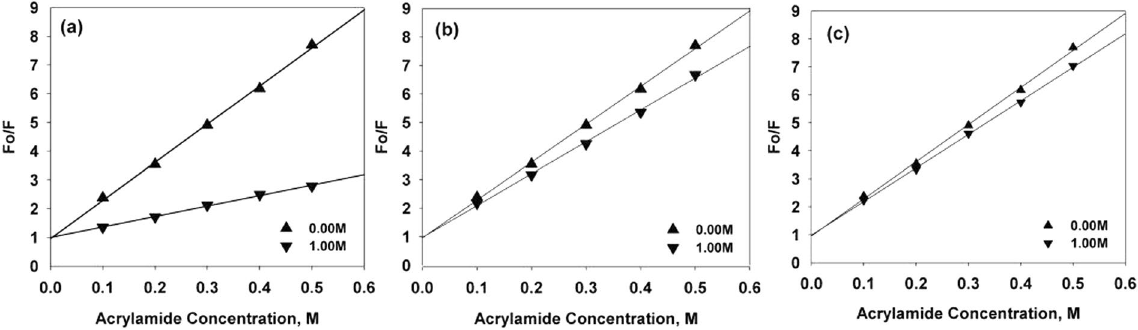
Figure 2. Fluorescence quenching of α -casein. Fluorescence quenching of α -casein in presence of 1 M of TMAO ( a ), sarcosine ( b ) and betaine ( c ). Symbols at the right bottom corner represent concentration of TMAO, sarcosine and betaine. These data were collected immediately after the sample preparation.